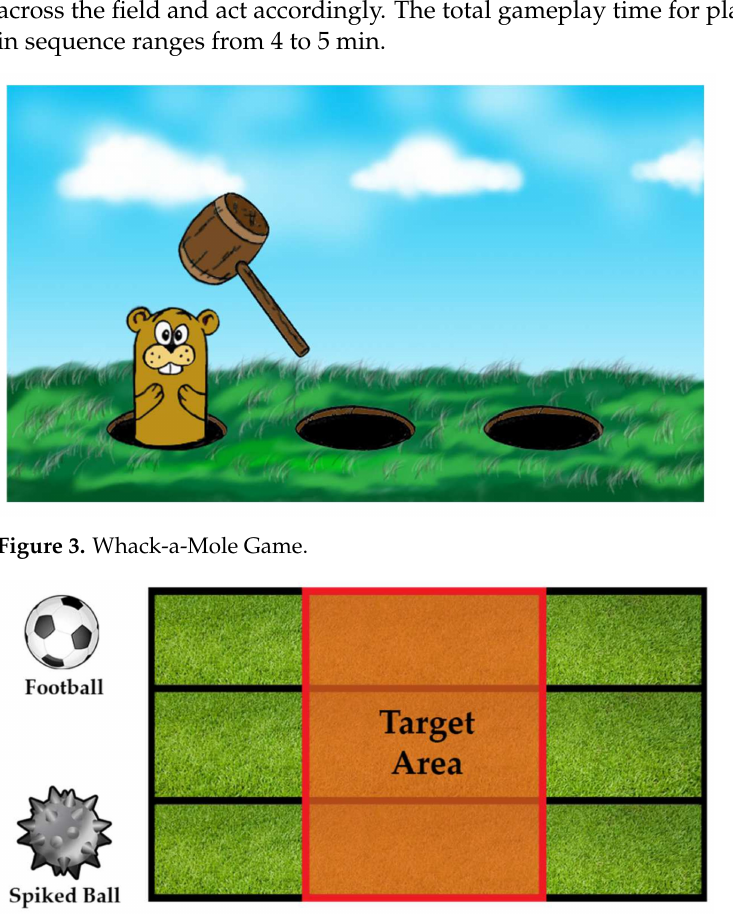
Figure 4. Hit-the-Ball Game. The subject has to distinguish between the two ball types and press the correct button when the football reaches the target